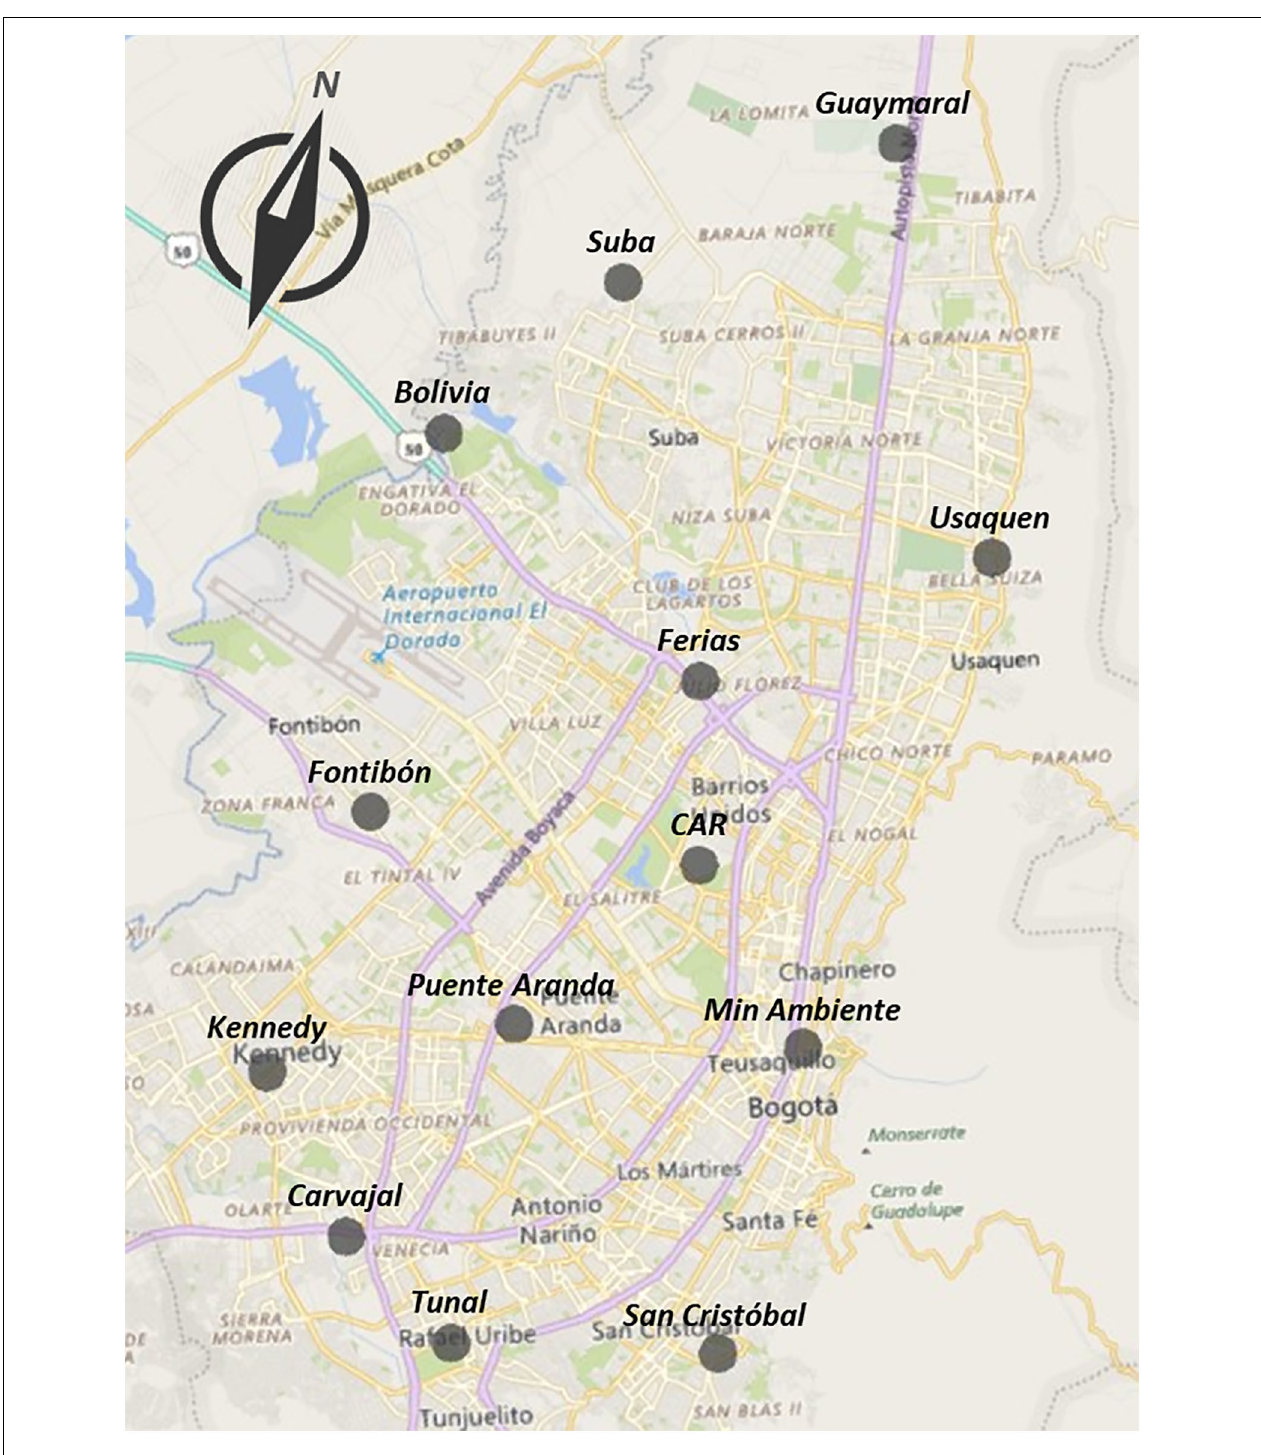
FIGURE 2 | Map of Bogotá urban area with the geographical location of the air quality monitoring